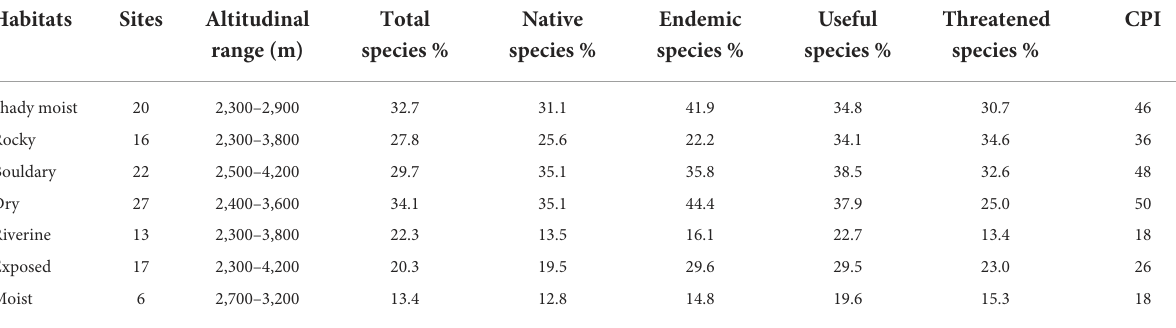
TABLE 3 Calculated CPI value of different habitats within GWLS. Habitats Sites Altitudinal